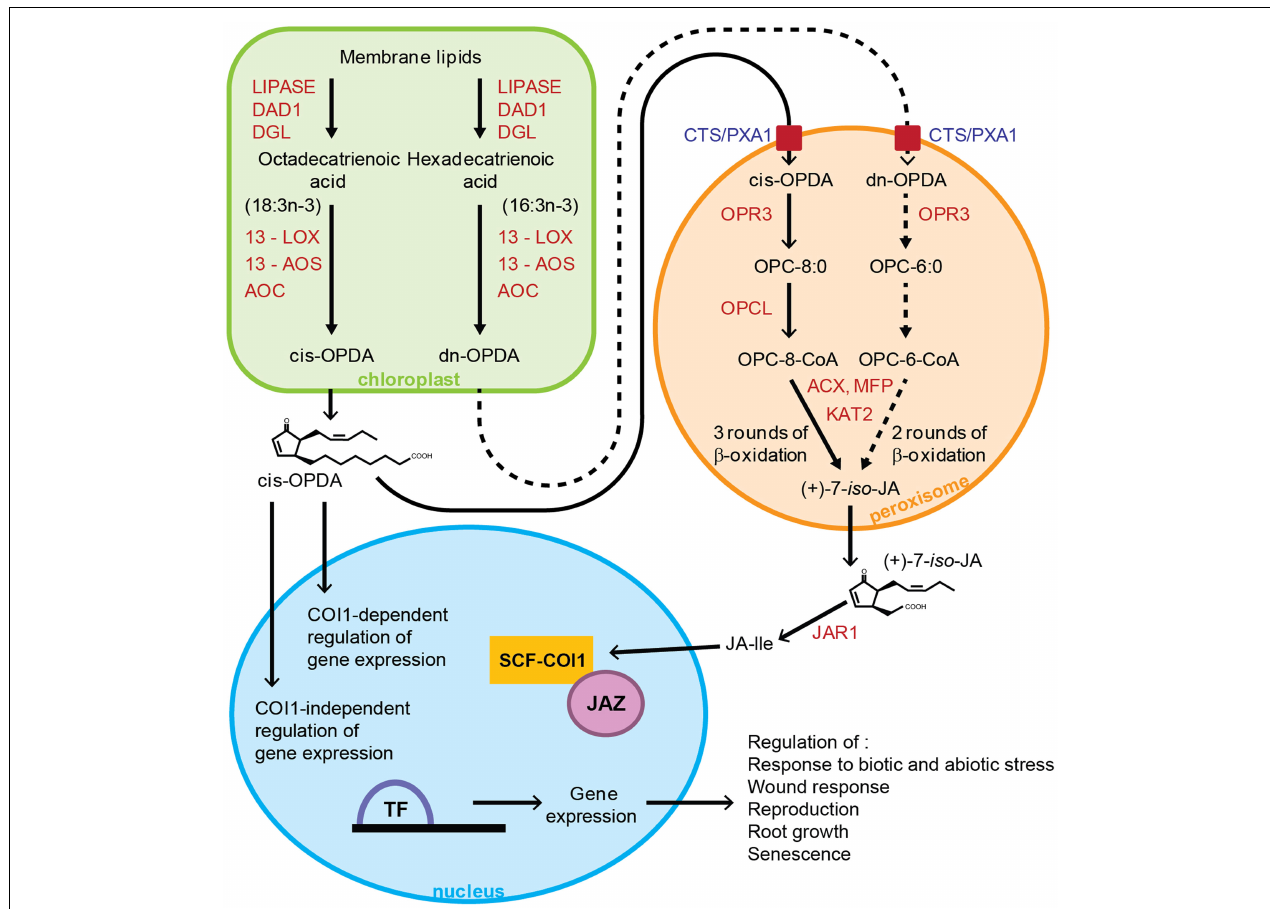
FIGURE 1 | Oxylipin biosynthesis pathway and signal transduction in Arabidopsis thaliana . JA biosynthesis initiates in the plastid with release of octadecatrienoic acid or hexadecatrienoic acid from membrane lipids by lipases such as DAD1 and DGL. cis -OPDA and dn-OPDA are formed following sequential steps catalyzed by 13-LOX, 13-AOS, and AOC. cis -OPDA is transported to the peroxisome via the CTS transporter, where after reduction by OPR3, OPC-8:0 is formed.This is activated to its CoA ester by OPCL1, which then undergoes three rounds of β -oxidation catalyzed by ACX, KAT, and MFP to give ( + )-7- iso- JA. JAR1 catalyzes formation of the amino acid conjugate JA-Ile from JA in the cytosol, which is the active form of the hormone involved in JA signaling. JAZ proteins repress expression of JA-responsive genes. In response to JA-Ile, the JAZ proteins are targeted by SCF COI1 for degradation, thus leading to JA-dependent gene expression and ultimately the regulation of various